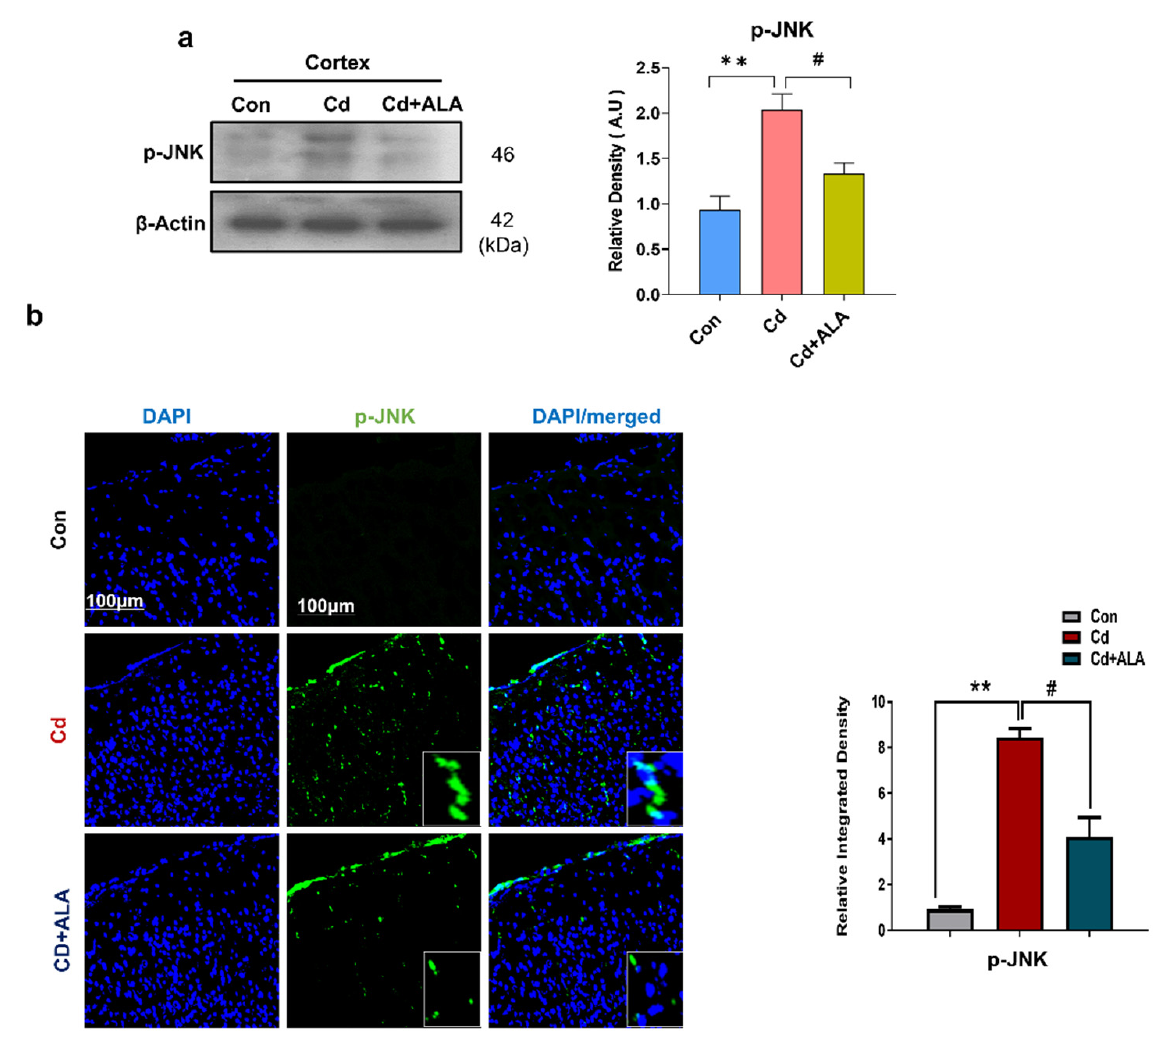
Figure 2. ALA reduces the increased expression level of p-JNK against Cd. ( a ) shows a Western blot result for p-JNK in mouse brain ( n = 5 mice per group; the number of experiments = 3); ( b ) confocal microscopy image for p-JNK; magnification 10 × , scale bar 100 um and high-resolution, statistical analysis of one-way ANOVA with Tukey’s posthoc test was used for comparisons among the different groups. Significantly different from the vehicle-treated control group, #, significantly different from the Cd-treated mouse group. Significance: ** p < 0.01; # p < 0.05.